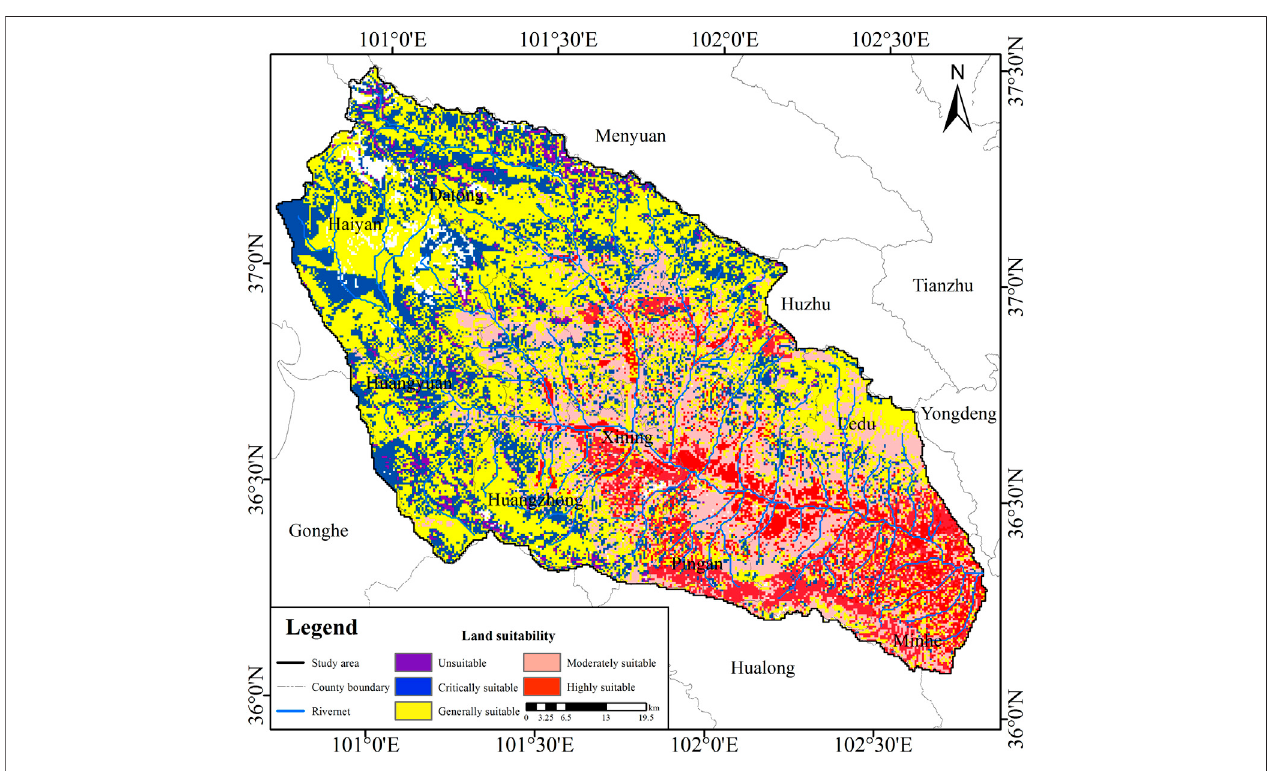
FIGURE 3 | Overall land suitability grade map of the Huangshui River Basin.